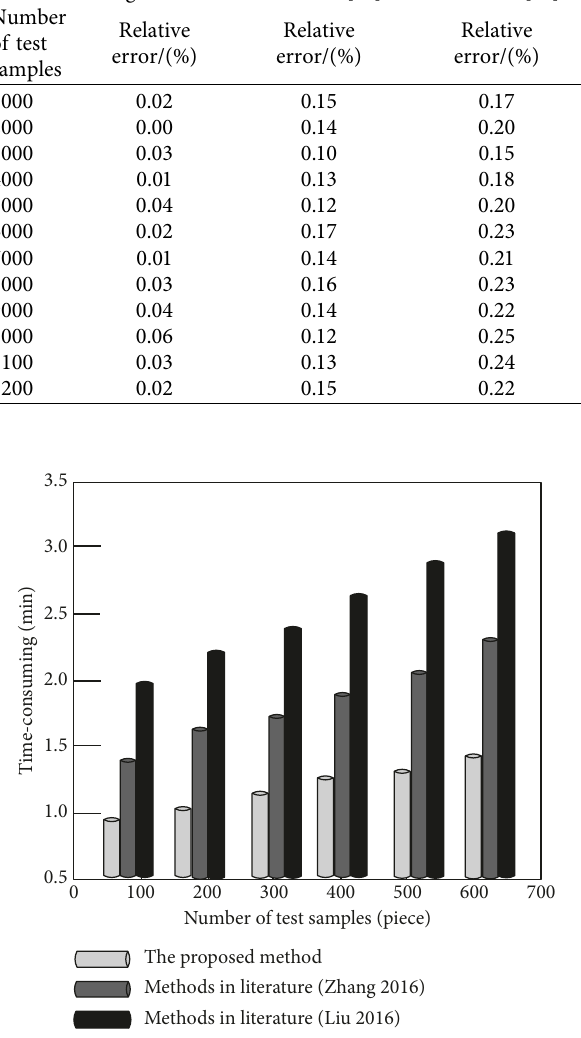
Figure 4: Comparison results of time consumption of three